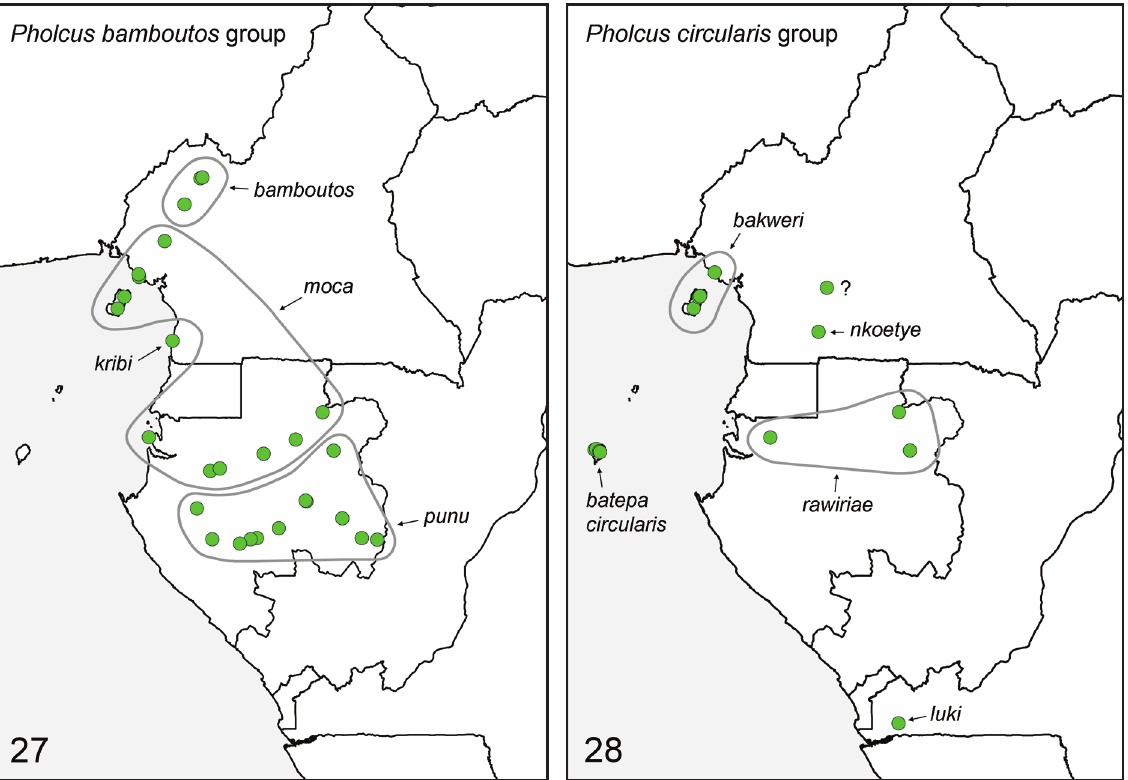
Figs 27-28. Known distributions of the bamboutos and circularis species groups ( sensu Huber 2011b) of Pholcus Walckenaer, 1805 in Central Africa. The question mark denotes an undescribed species represented by a single male in